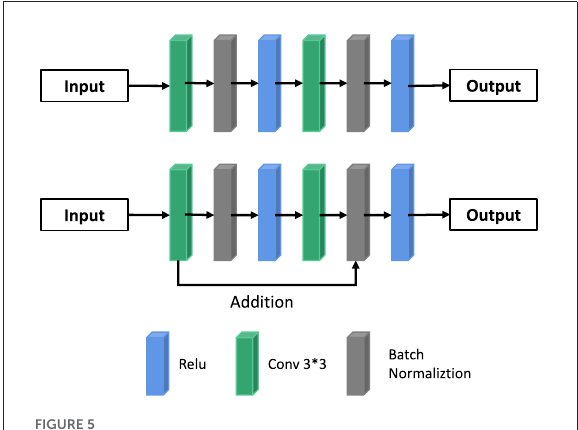
FIGURE5 Ordinary convolution block and residual convolution block.